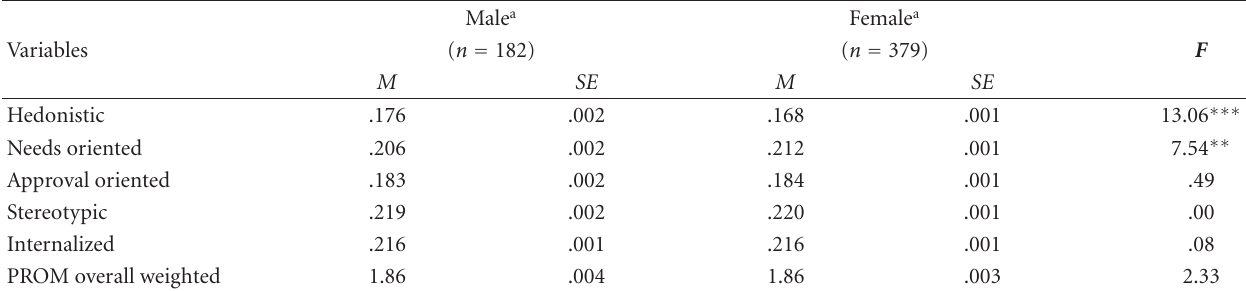
Table 4: Comparison of prosocial reasoning between males and females, with age as